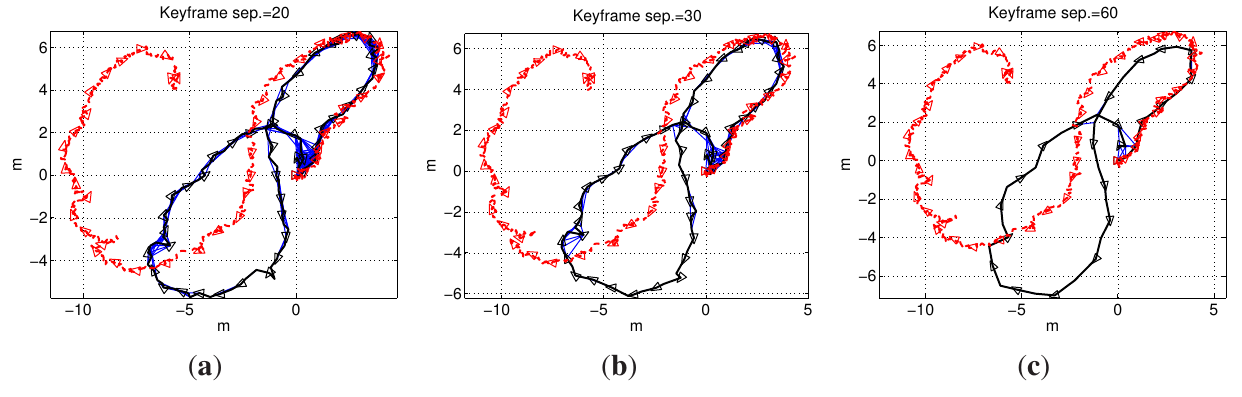
Figure 18. Visual odometry (dashed red line) and SLAM (continuous black like) pose estimates in Port de Valldemossa using keyframe separations of: ( a ) 20 frames; ( b ) 30 frames; and ( c ) 60